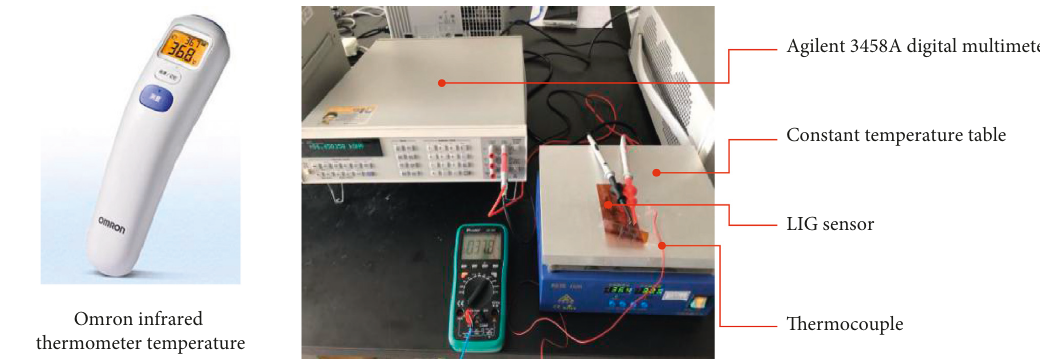
Figure 2: Temperature response test method of the